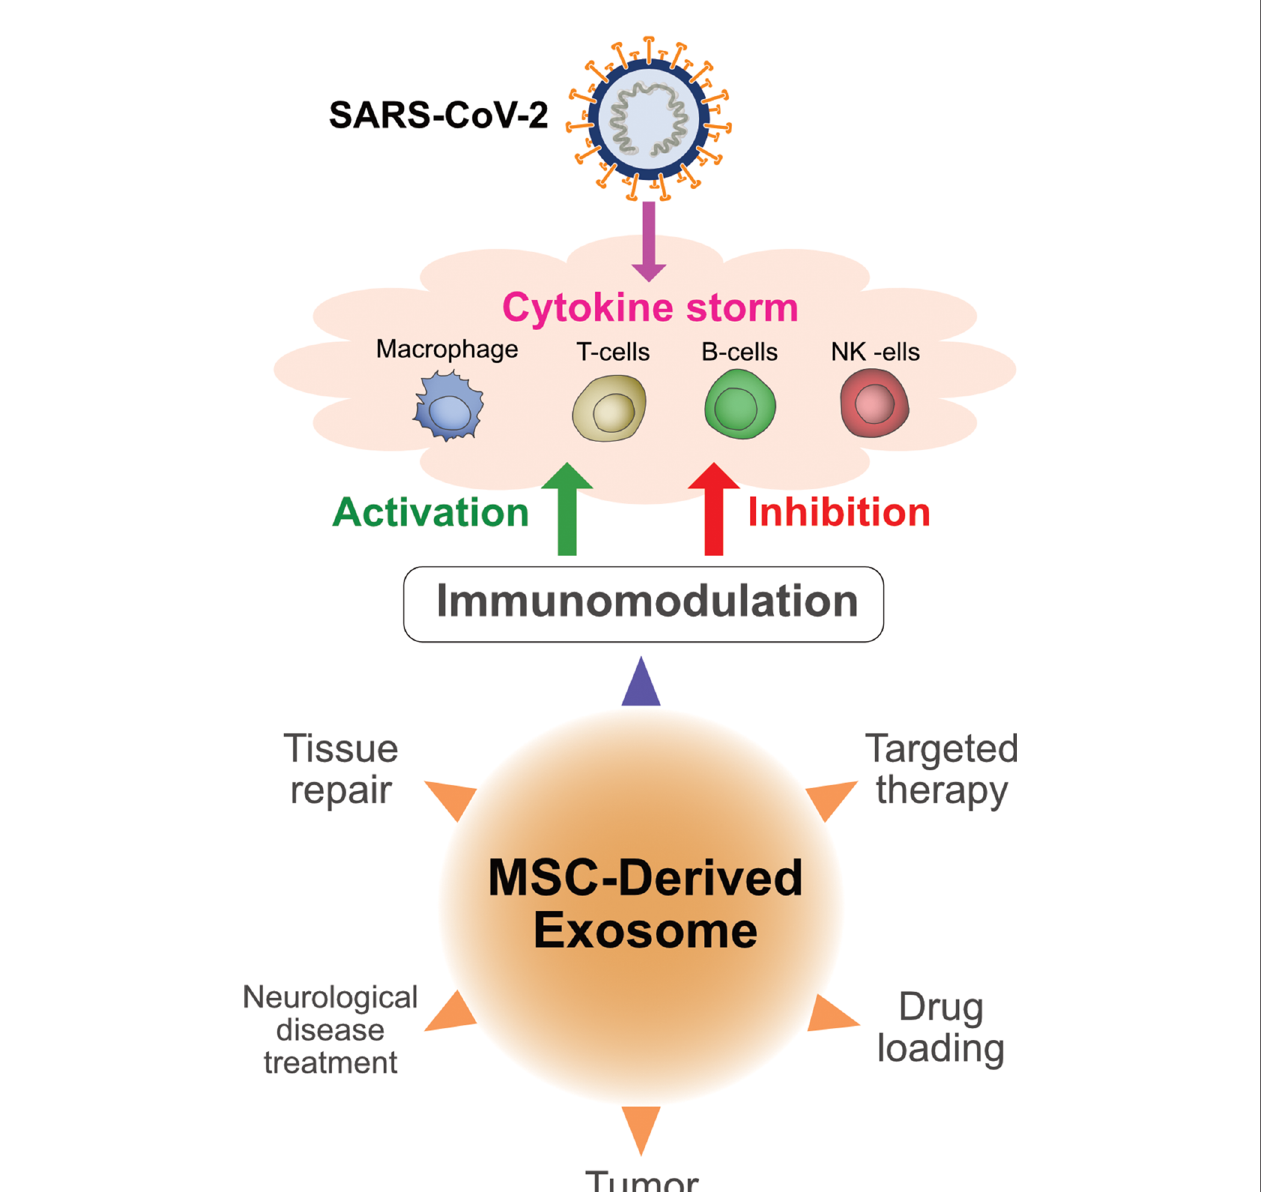
FIGURE 4 | Multifunctional aspects of exosomes derived from mesenchymal stem cells and immunomodulatory effects of exosomes on